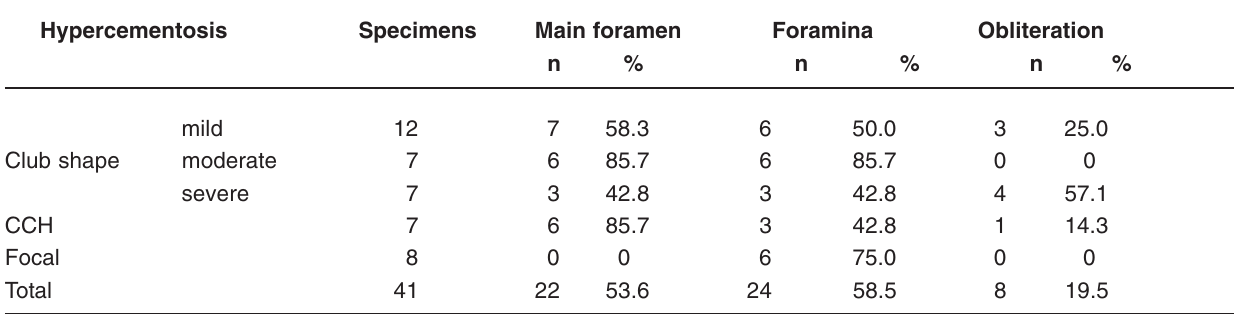
TABLE 2- Apical main foramen and foramina observed in the 41 examined Hypercementosis